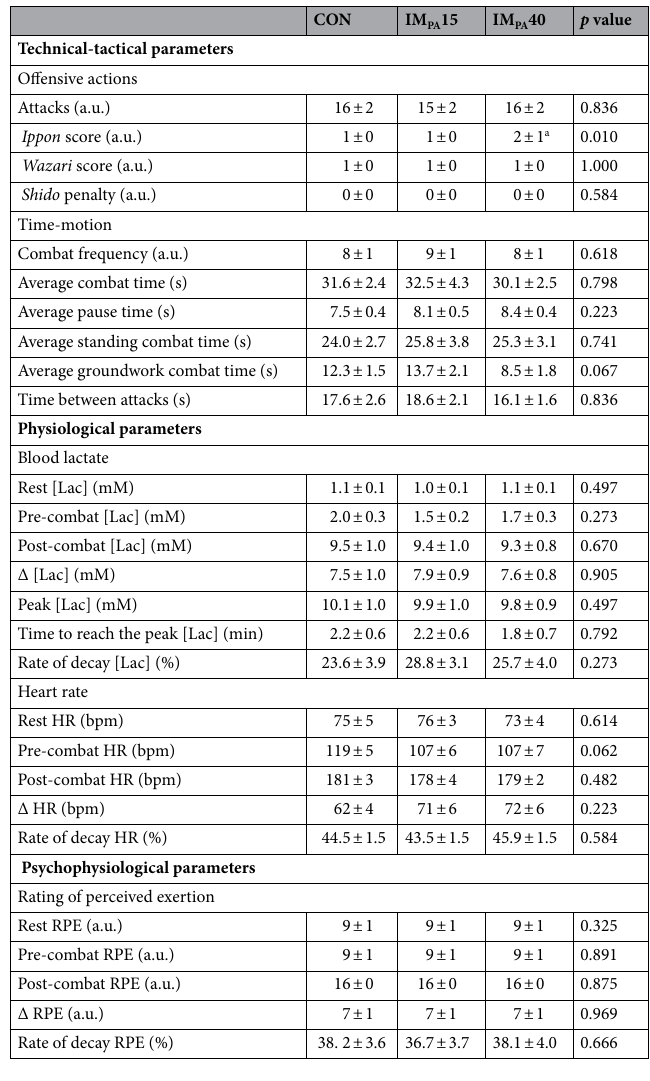
Table 2. Technical-tactical parameters of offensive actions of combat and time-motion and physiological parameters of blood lactate [Lac], heart rate (HR) and psychophysiological parameters of rating